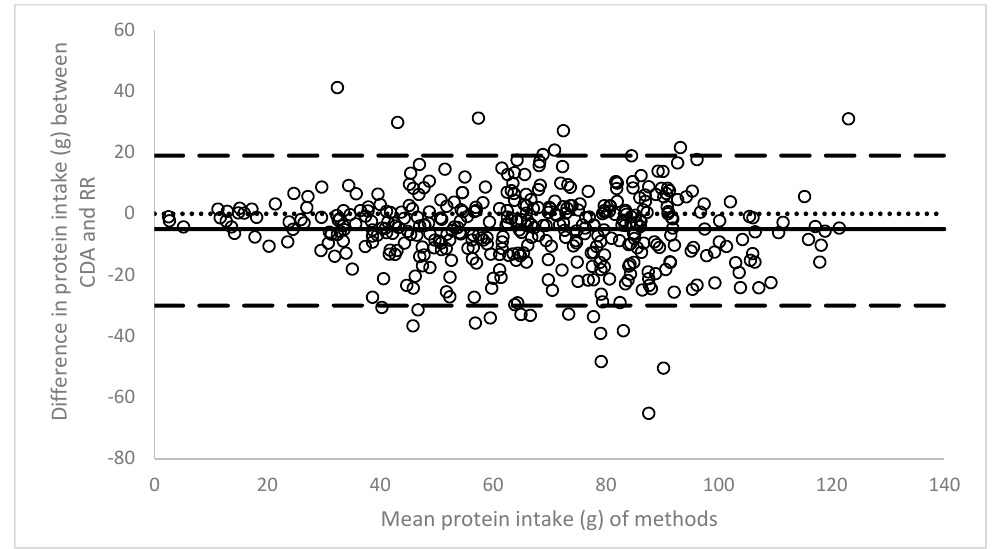
Figure 3. Bland-Altman plot of protein intake calculated using computerised dietary analysis (CDA) and ready reckoner (RR) analysis ( n = 413).